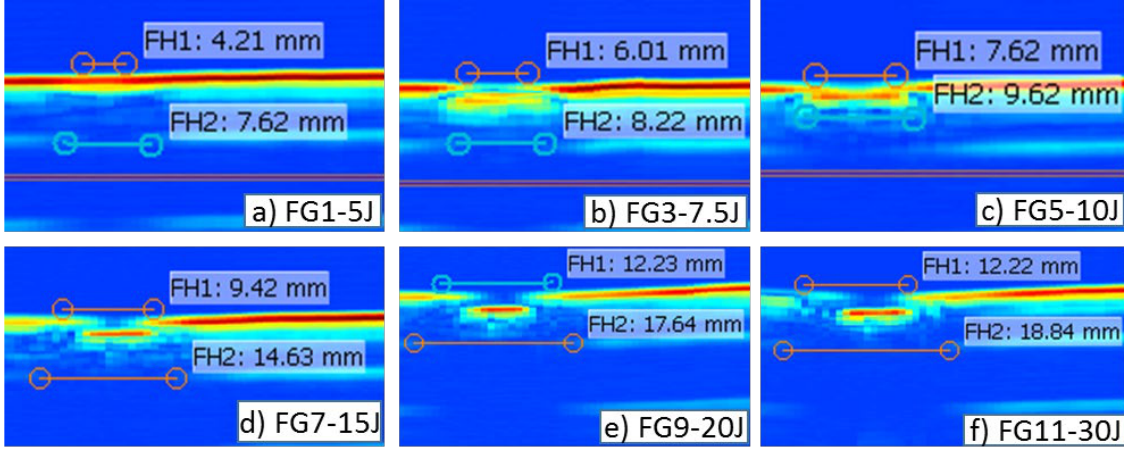
Figure 2. Damage characterization B-Scans—Glass Fiber—5 J to 30 J ( a – f ).